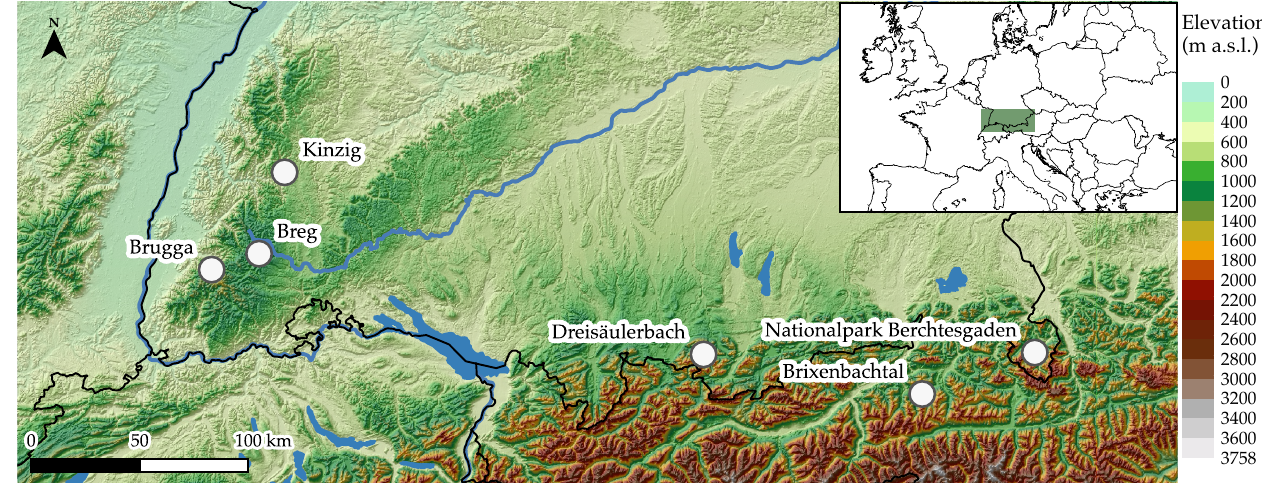
Figure 1. Overview of the study areas. Figure created with QGIS 3.16.1. DEM data based on